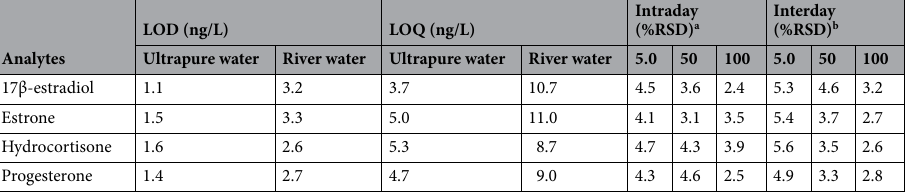
Table 2. Limits of detection and quantification from ultrapure water and river water samples. a Same day